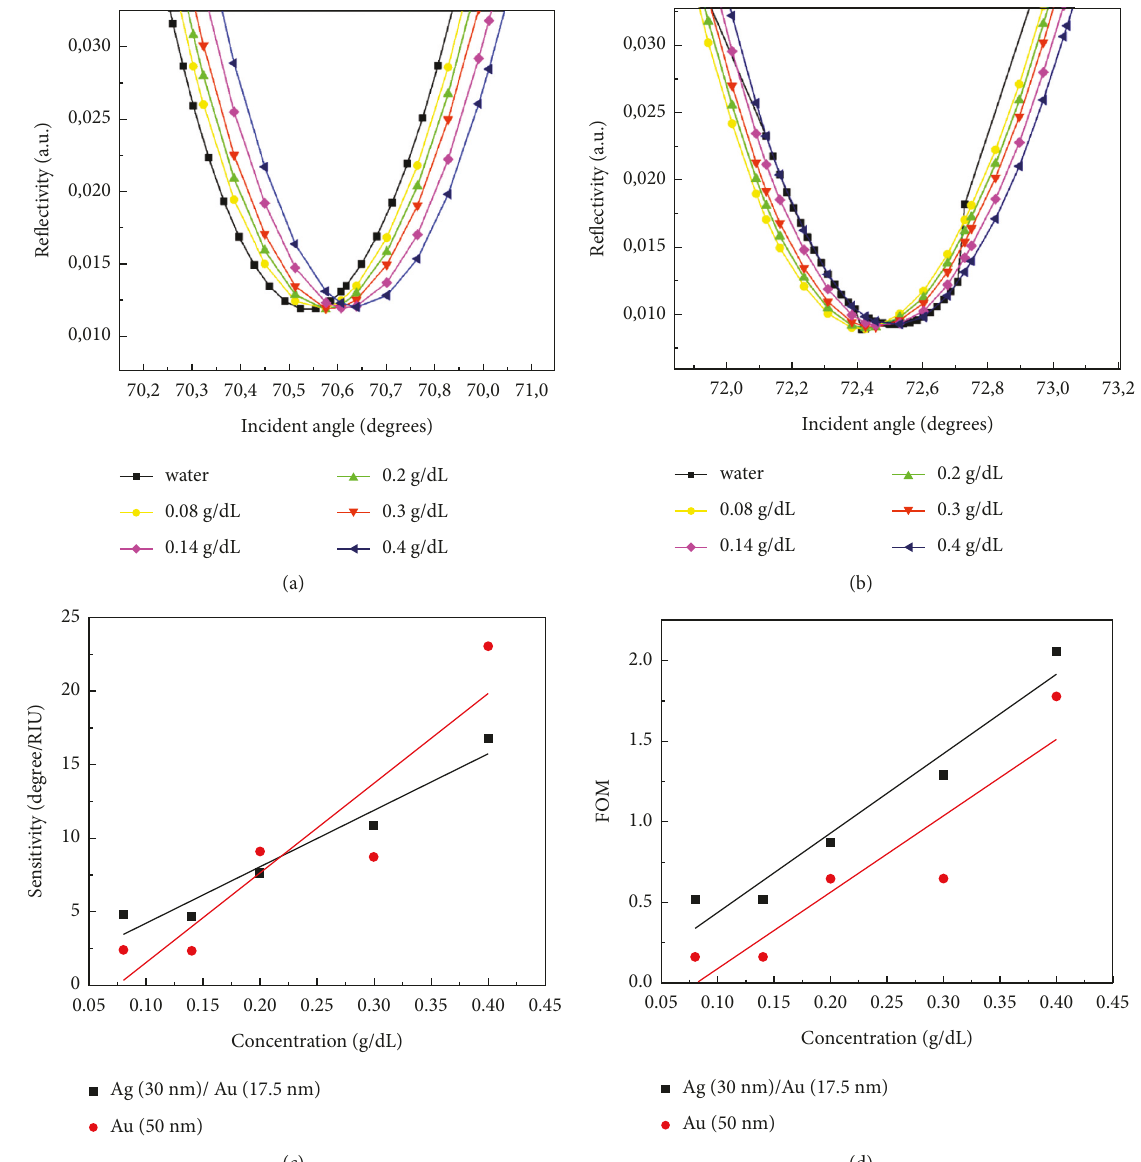
Figure 5: SPR response curve with a different Kretschmann configuration of a (a) 30nm film for different glucose concentration, and a corresponding performance comparison in (c) sensitivity and (d) figure of merit